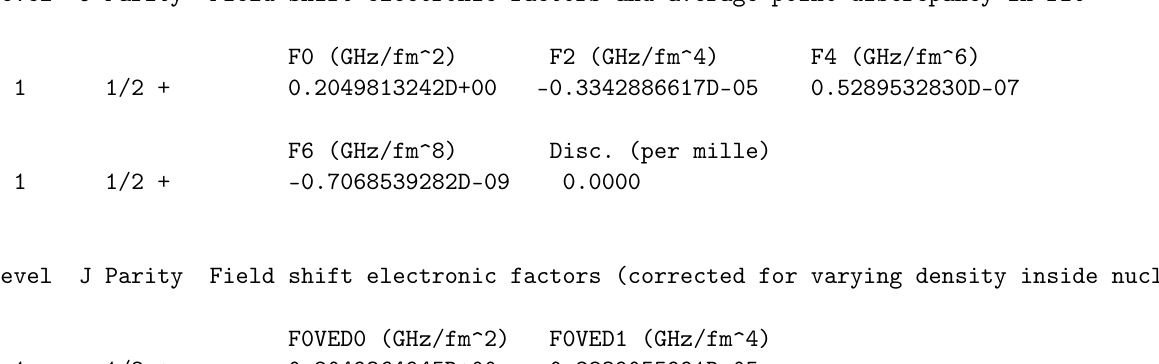
The normal and specific mass shift parameters are those of the three terms defined in TP Sections 3.3, Equations (73) and (74). The field shift electronic factors F 0 , F 2 , . . . , F 6 are the ones defined in TP Section 3.3, Equation (79). F